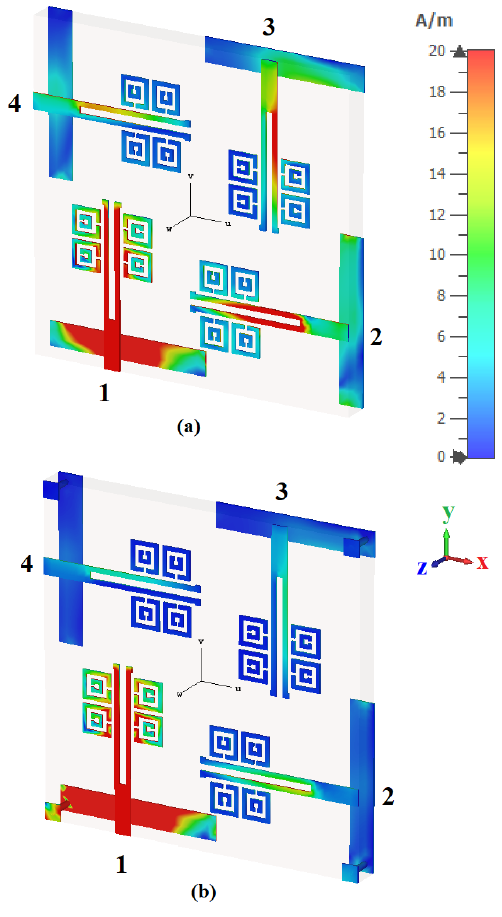
Figure 9. Surface current distributions at 5.8 GHz of the four-element antenna configuration: ( a ) without vias and ( b ) with vias.